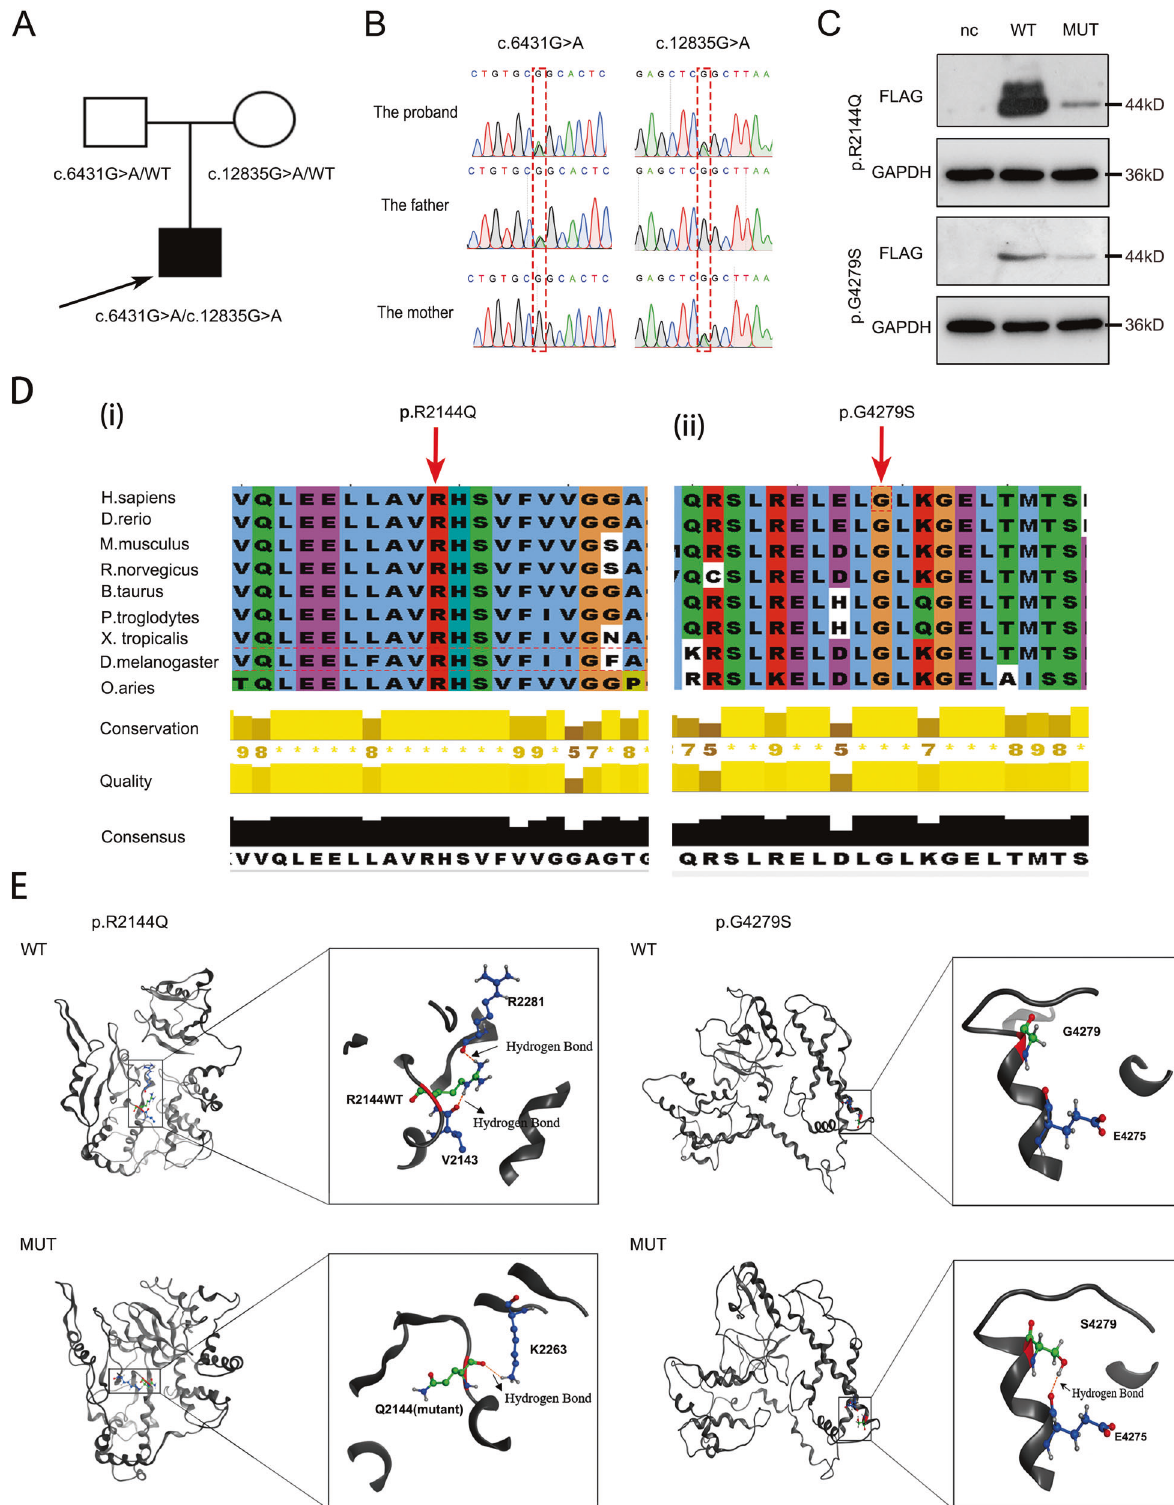
Fig. 1 Compound heterozygous mutations in DNAH9 reduce protein itself expression. A Family pedigree structure of the patient. The black squares represent the proband. B Sanger sequencing identifying the compound mutations in the patient and mutation carrier parents. C Western blot analysis of the DNAH9 fragment in HEK293 cells transfected with wild type and mutant plasmids. GAPDH served as a loading control. D Multiple sequence alignment of the mutated amino acid site in DNAH9 protein in different species. Red arrows indicate the position of the variants. E The protein three-dimensional structural alteration of p.R2144Q and p.G4279S variants. The R2144 and Q2144 residues are shown in green, R2144 and its adjacent V2143/R2281residue form a hydrogen bond (yellow dotted line), respectively, whereas Q2144 form an aberrant hydrogen bond with K2263. The G4279 and S4279 residues are shown in green. G4279 do not form a hydrogen bond with other residues in wild type, whereas mutant S4279 can form a hydrogen bond with E4275. Cell Death and Disease (2022)